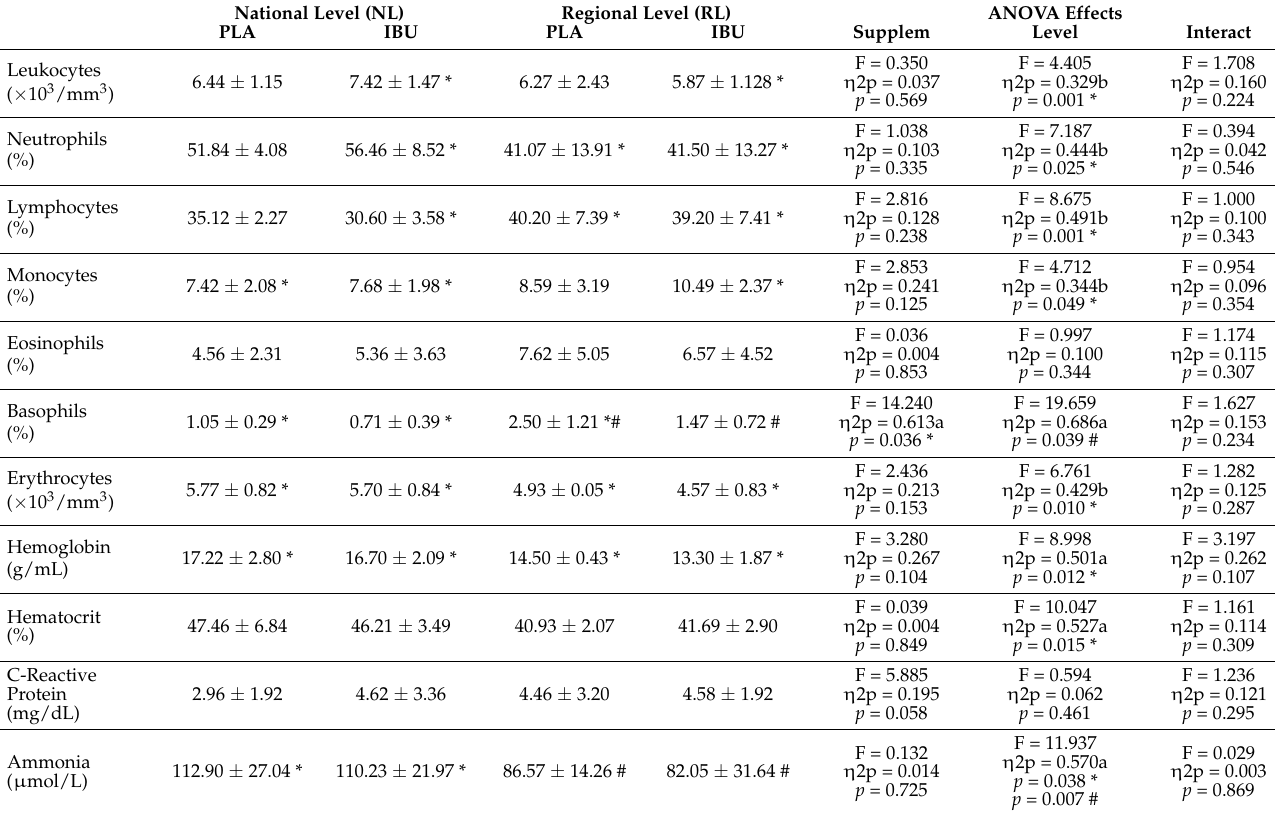
Table 2. Blood markers with the use of placebo (PLA) and ibuprofen (IBU) at different training levels.